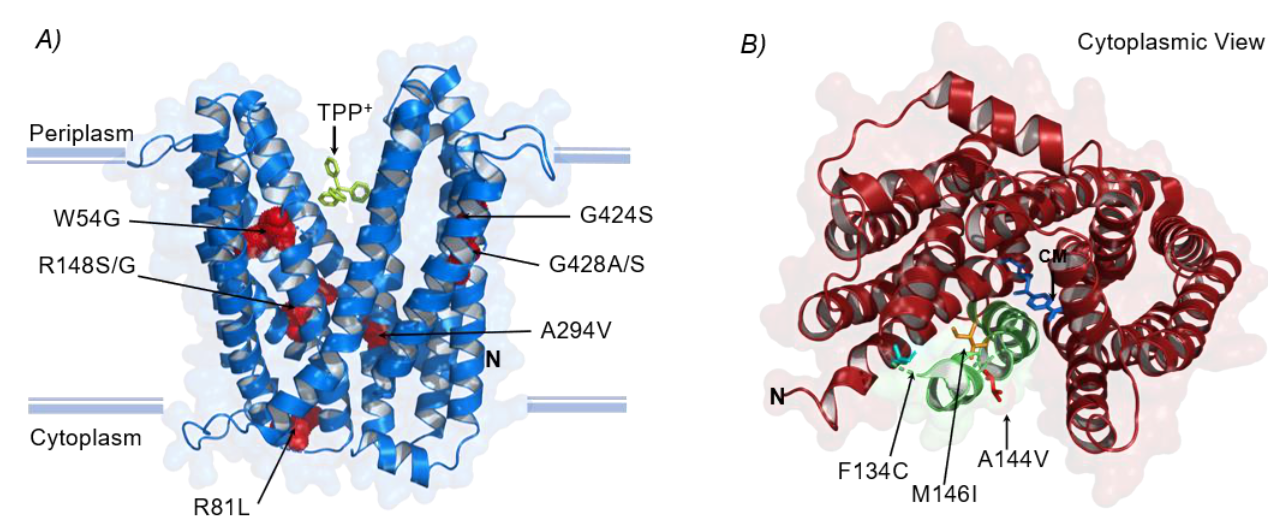
Figure 6. Overview of identified mutations affecting mdtK and mdfA . ( A ) Side on view of mdtK with TPP + (lemon-green sticks) bound in the periplasmic side. Depicted is the predicted architecture of mdtK aligned with the crystal structure of the homologous multidrug effluxer norM from Neisseria gonorrhoeae in complex with TPP + (PDB 4huK). Amino acid substitutions (red spheres) represent all mutations reported (replicates represented once and details are in Table 2). ( B ) Cytoplasmic view of mdfA in the outward conformation (PDB 4zow) in complex with CM (blue sticks). Green ribbon represents TM5, and arrows indicate the observed amino acid substitutions.